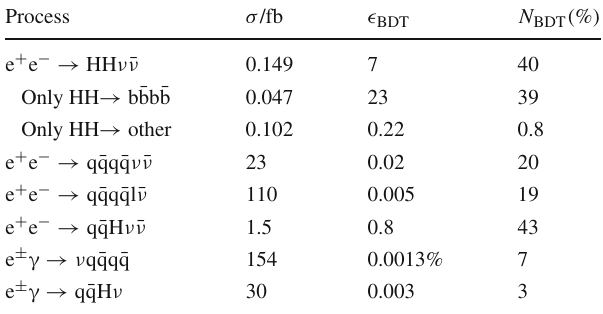
Table 3 Cross sections, σ , selection efficiencies, (cid:14) BDT , and expected number of events in the HH → b ¯ bb ¯ b signal region, N BDT , at √ s = 1.4TeV for L = 2 . 5ab − 1 . The cross sections are for